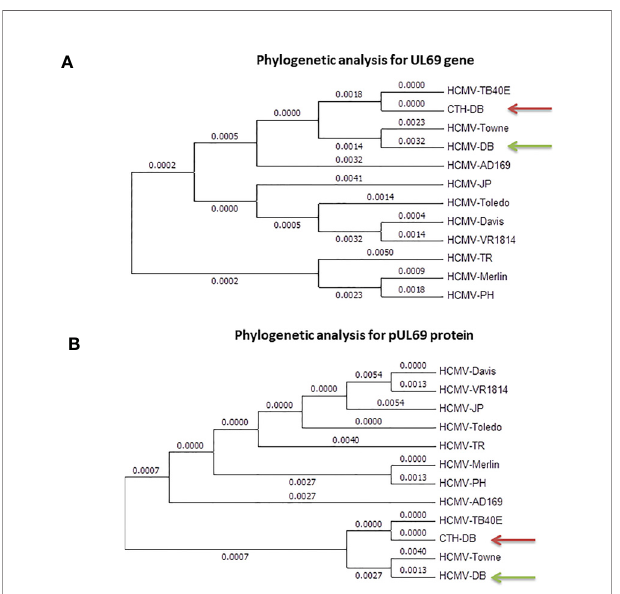
FIGURE 3 | Phylogenetic analysis of UL69 gene and pUL69 protein present in CTH cells. Phylogenetic analysis of UL69 gene (A) and pUL69 protein (B) present in CTH cells compared to the original HCMV-DB strain in addition to other clinical and laboratory-adapted HCMV strains. This analysis was performed over three independent experiments.